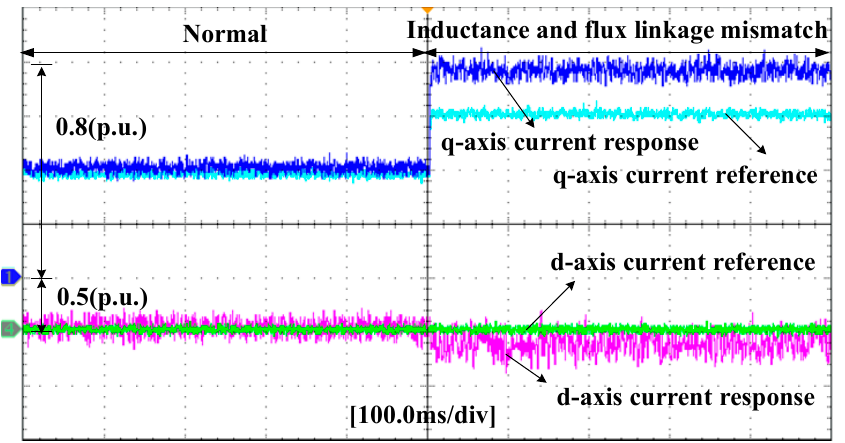
Figure 15. Experimental results of the conventional PCC method under inductance and flux linkage parameter perturbations.